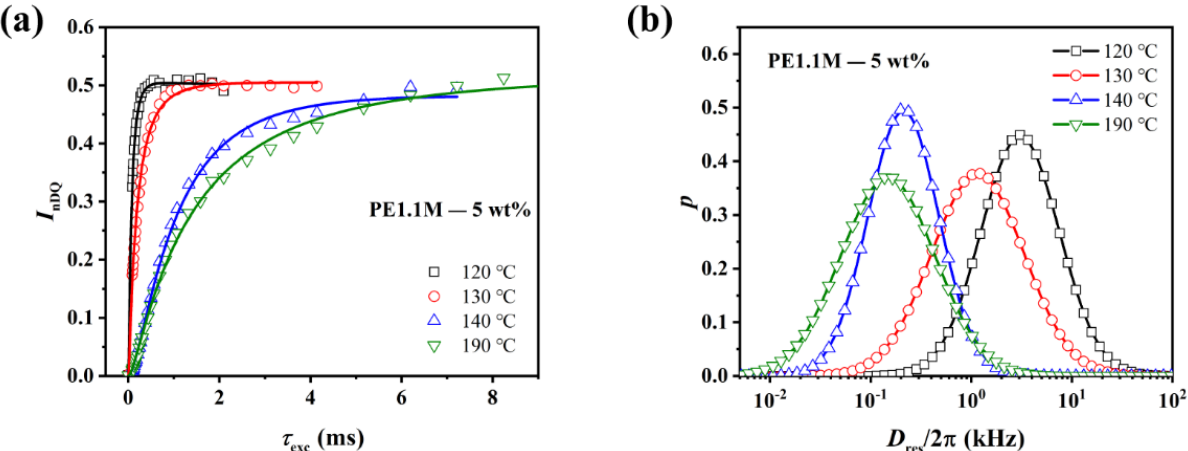
Figure 6. Temperature dependence of ( a ) nDQ curves and ( b ) D res distribution curves for PE1.1M — 5 wt%. The solid lines in ( a ) represent fitting curves of I nDQ .